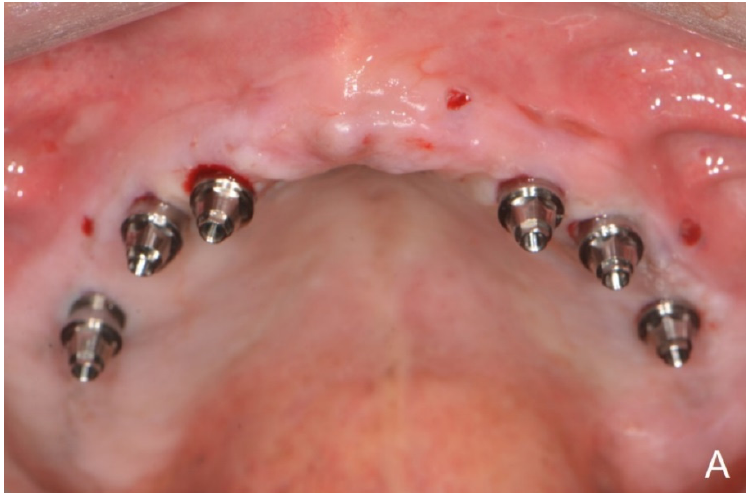
Figure 4. Interim restoration with tissue-colored composite resin on the gingival area. 7. After implant placement, remove the surgical guide and connect the abutment to the implant (Figure 5A). Then, connect the interim cylinder to the abutment (Figure 5B). Connect the interim prosthesis to the interim cylinder by adding acrylic resin (Duo- Link; Bisco Dental, Schaumburg, IL, USA) to the space between them using a syringe (Figure 5C,D). After allowing the resin to polymerize, remove the flange part of the interim prosthesis (Figure 6). Screw the attached part of the prosthesis to the abutment. Check for occlusal interferences and make occlusal adjustments if necessary.